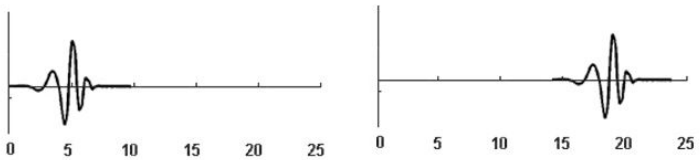
Figure 3. E ff ect of changing the translation parameter on wavelet Figure 3. Effect of changing the translation parameter on wavelet [4].